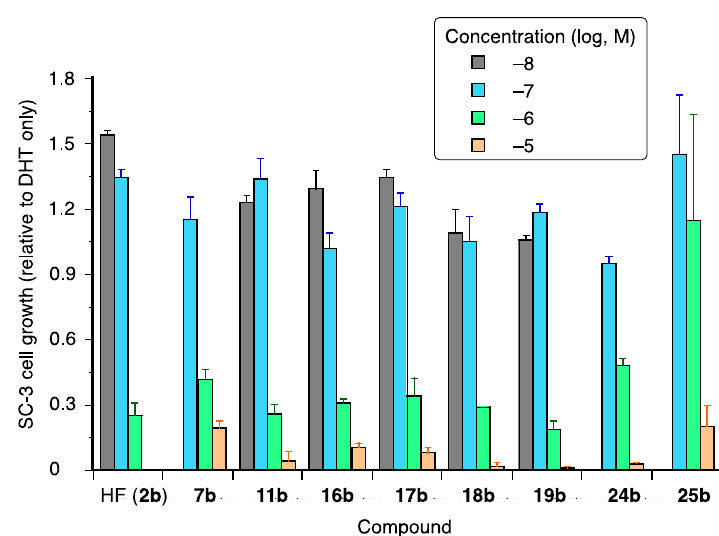
Figure 3. Dose-dependent growth inhibition of selected coumarinamides in the presence of 1 nM DHT. The vertical scale is SC-3 cell growth, normalized to that of DHT-treated cells without the test compound, which is taken as 1.